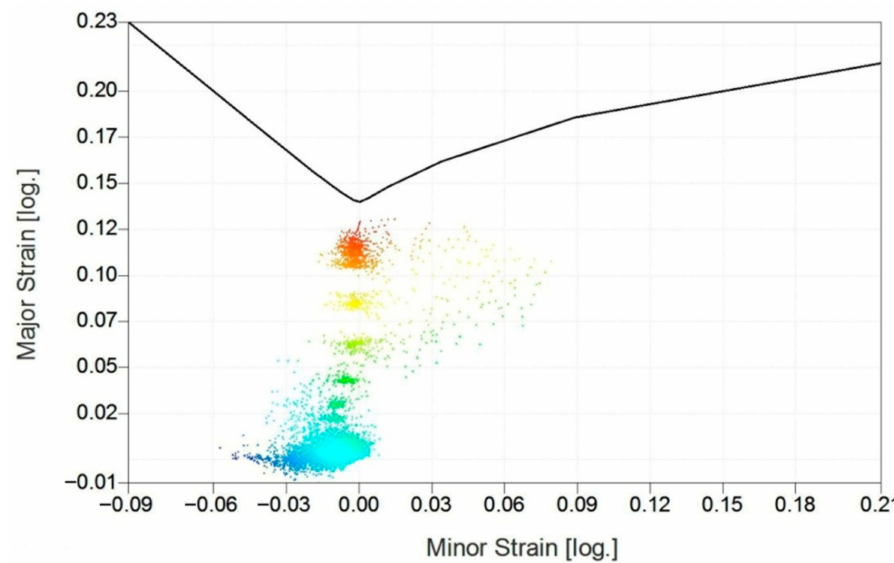
Figure 15. Forming limit diagram for a panel made of 1-mm-thick EN AW-2024-T3